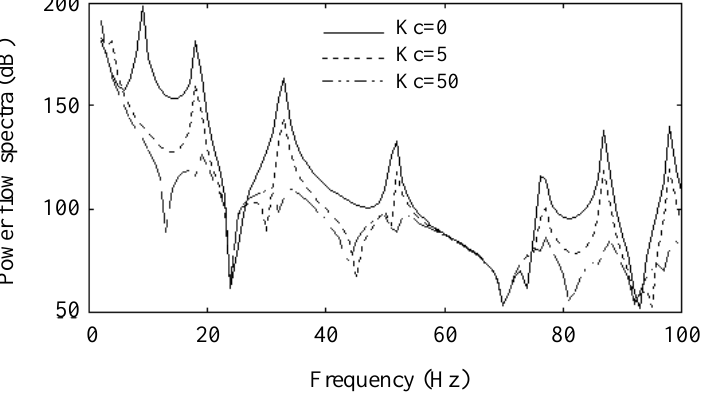
Fig. 9. Hybrid control of power flow for various values of feedback